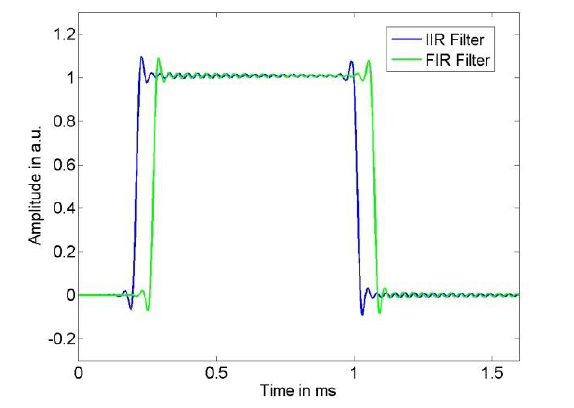
Figure 5. The compensated output signals resulting from the IIR and the FIR compensation filter for thebroad-banded sensor input signal.